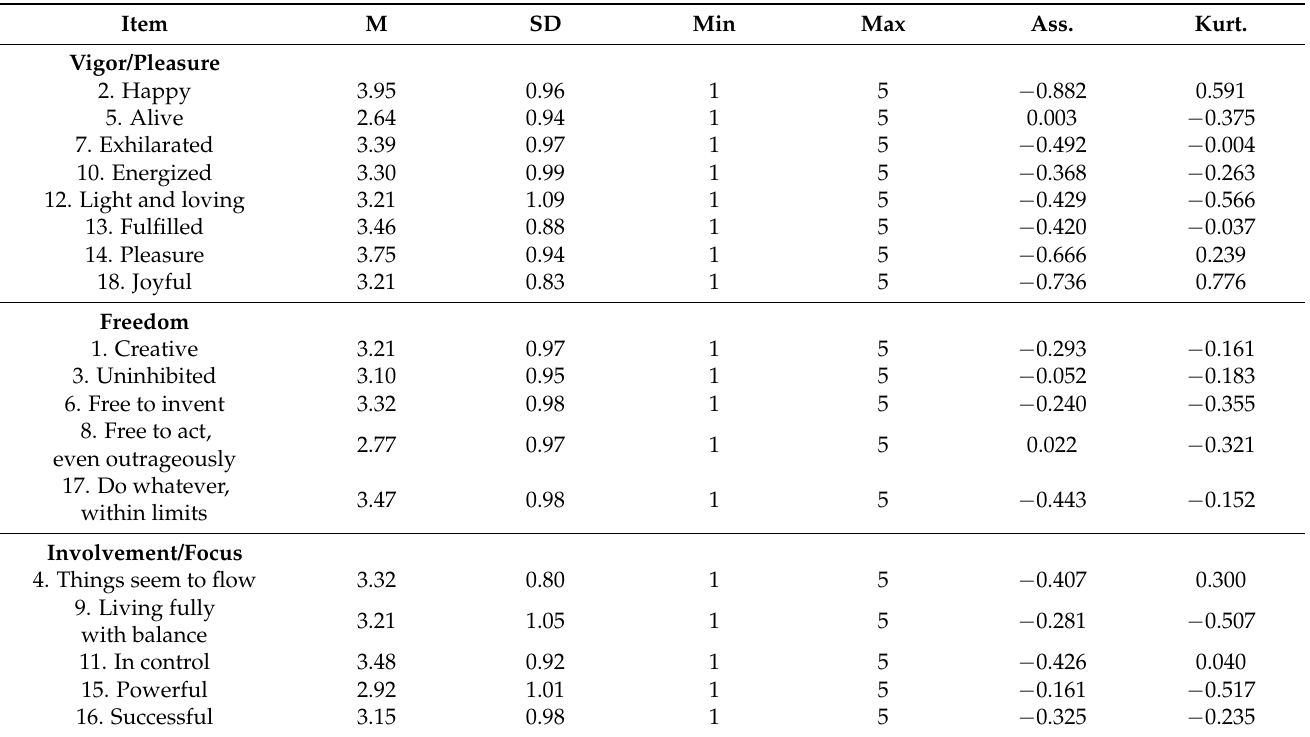
Table 2. Descriptive statistic of the 3-factors